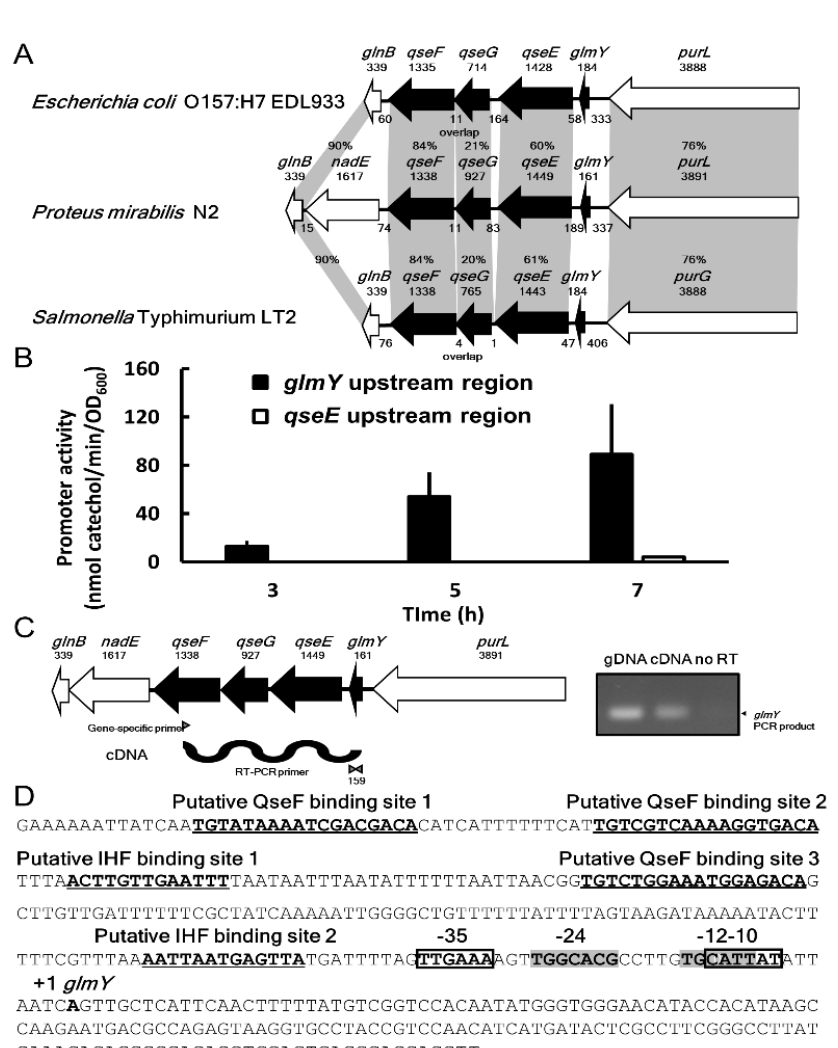
Figure 1. The glmYqseEGF gene locus in P. mirabilis N2. ( A ) The P. mirabilis glmYqseEGF gene locus corresponds to the similar locus in E. coli O157:H7 EDL933 and Salmonella Typhimurium LT2 with corresponding genes in shadows. An amino acid sequence analysis of the locus in these strains was performed using position-specific iterative BLAST. The percent amino acid identities of PurL, QseE, QseG, QseF and GlnB between P . mirabilis N2 and E. coli O157:H7 EDL933 or Salmonella Typhimurium LT2 are shown. The number above each arrow represents the gene length (bp). The intergenic space or overlap in terms of base pairs is also shown. ( B ) The promoter activities of glmY ( − 381 to − 3 from putative glmY transcriptional start site) and qseE ( − 553 to − 6 from qseE start codon) upstream region. ( C ) The glmY - qseE-qseG-qseF constitute an operon by gene-specific reverse transcription PCR. cDNA was synthesized by the qseF -specific primer and then the glmY DNA fragment was amplified by PCR. no RT, negative control; gDNA (genomic DNA), positive control. ( D ) The sequence of glmYqseEGF promoter region in P. mirabilis N2. The putative QseF and IHF binding sites are bold and underlined. The conserved σ 70 and σ 54 binding sites are indicated in boxes and shadows, respectively.